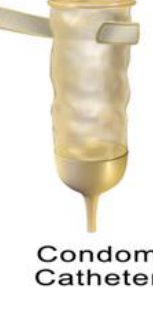
Figure 4. Condom catheter. Reprinted from ref. [16], under a creative common license (CC BY-SA